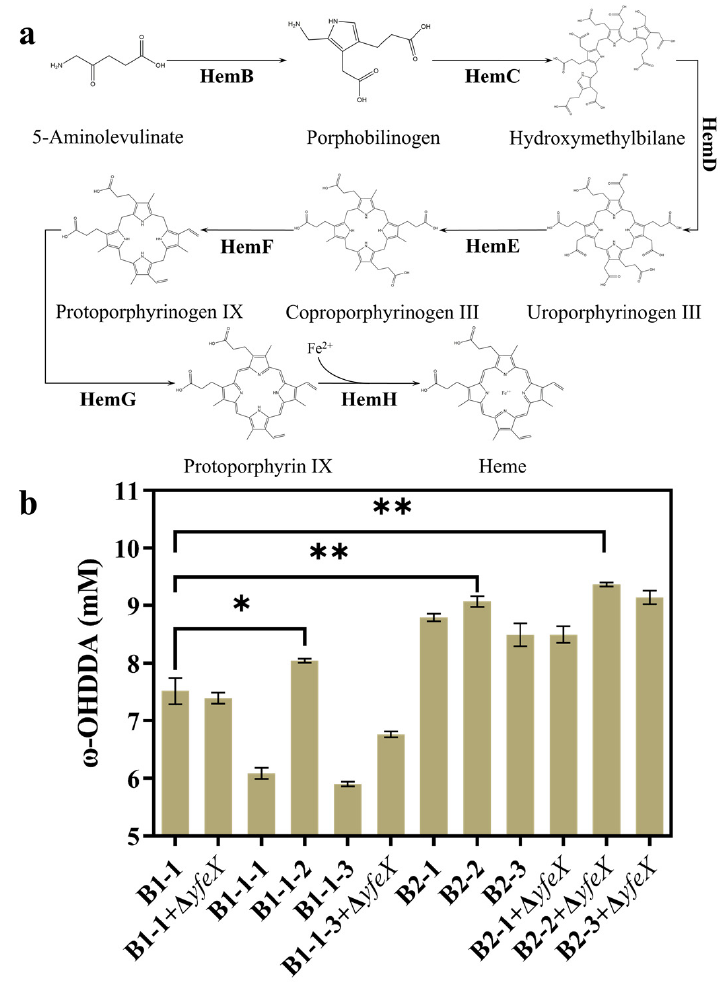
Figure 6. Enhancement of heme synthesis in E. coli . ( a ) Heme synthesis pathway of E. coli . ( b ) ω - OHDDA production in whole-cell systems modified with different strategies. B1-1 without the modification of heme synthesis was used as the control strain. Statistical analysis was performed by an unpaired two-tailed t-test. * 0.01 < p < 0.05; ** p < 0.01. B2-1, B2-2 and B2-3 used promoters with different strengths (P lac , P tac and P T7 , respectively) for hemB overexpression. The E-M1-3 plasmid was expressed in the control group and in each experimental group.